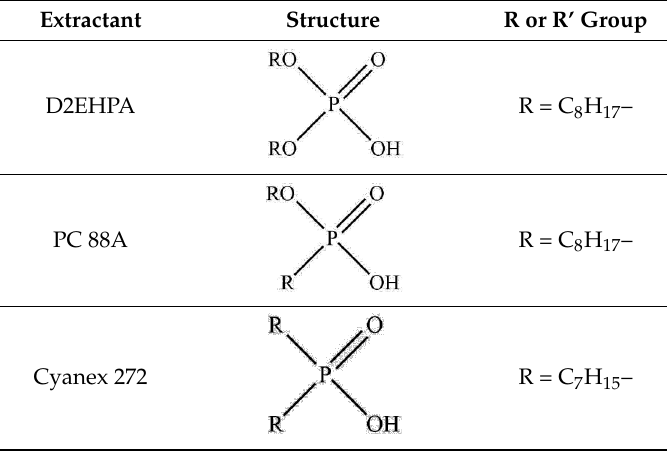
Table 1. Chemical structure of extractants used in the study.